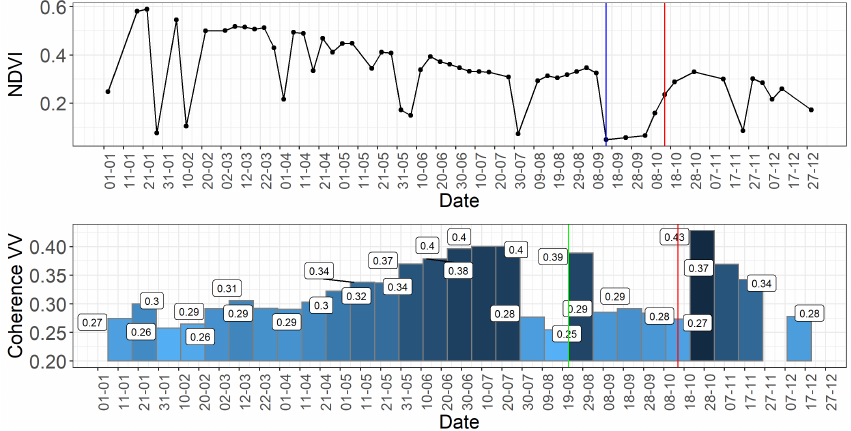
Figure 18. Example of false response of the optical algorithm due to cloudiness in September and false response of the SAR algorithm due to field works in August (cid = 197). Actual harvest date (red lines): 15 October 2018; harvest date according to the optical algorithm (blue lines): 15 September 2018; harvest date according to the SAR algorithm (green line): 22 August 2018.